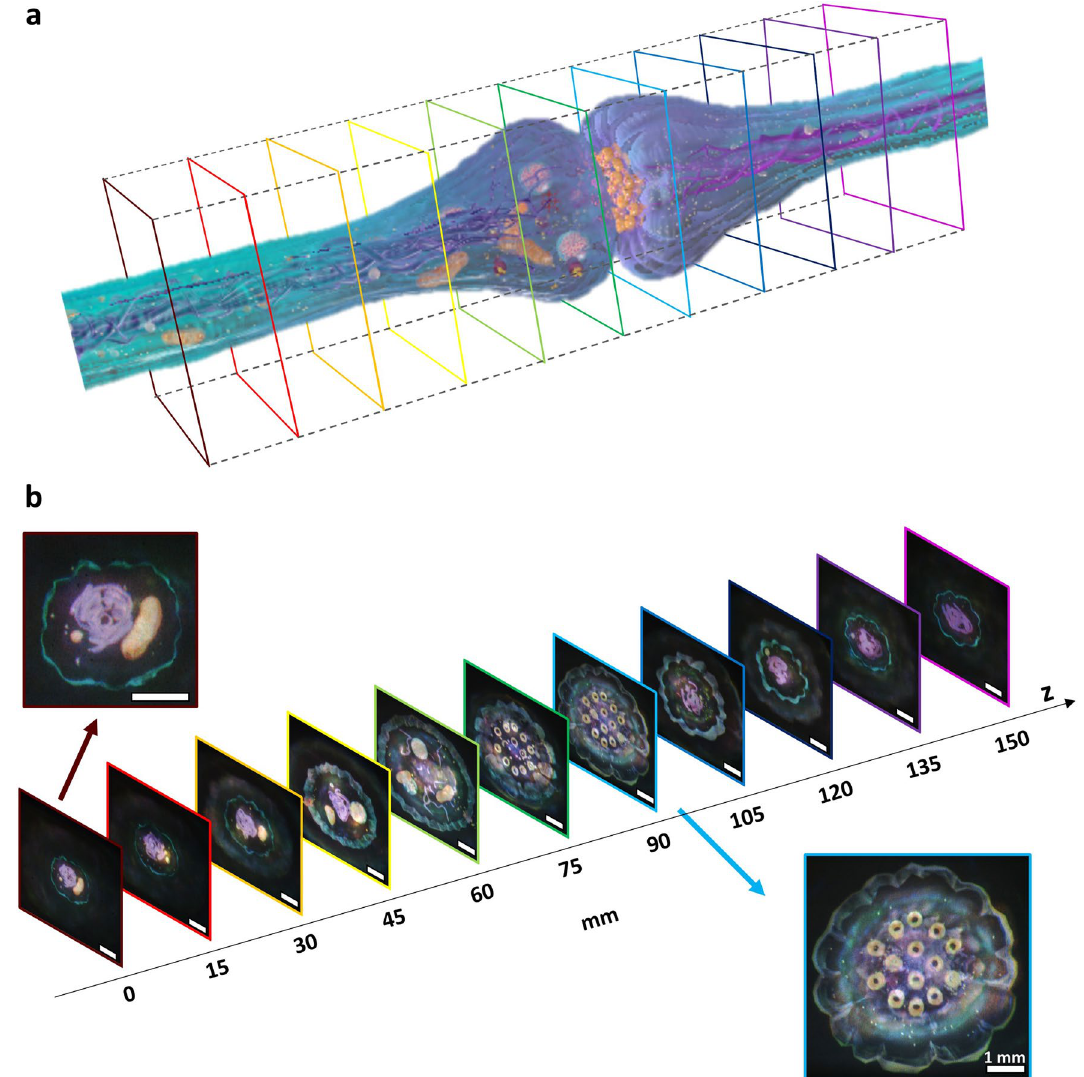
Figure 2. Tomographic 3D projection.( a ) Target 3D model ( Synapse ), purchased from Free 3D, All Rights Reserved. Eleven cross-section images are taken by using the 3D rendering software (’Autodesk Maya’). ( b ) Experimental results of the tomographic projection. The results are captured by shifting the camera from 0 to 150 mm in the z -axis. White lines denote length of 1